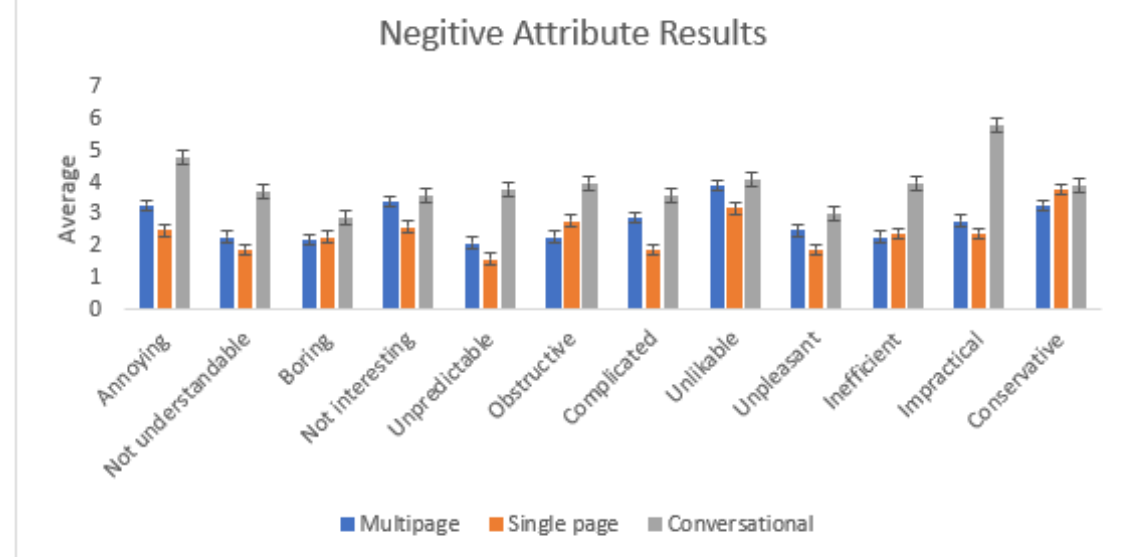
Figure 8. Bar chart showing negative attribute results of the User Experience Questionnaire for all three forms. The conversational form had higher averages for the negative attributes than those of the other two forms, which suggests that the conversational form had the least